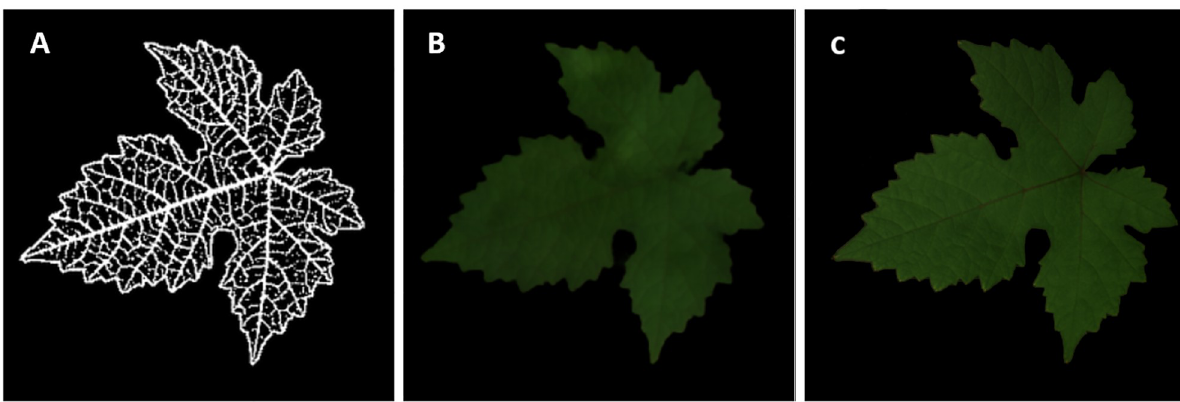
Fig 5. Translation from unseen real companion skeleton. A binarized leaf skeleton companion of a real leaf not belonging to the training set is passed through the generator of the Pix2Pix net to check. A: companion skeleton; B: synthetic colorized blade; C: real image.